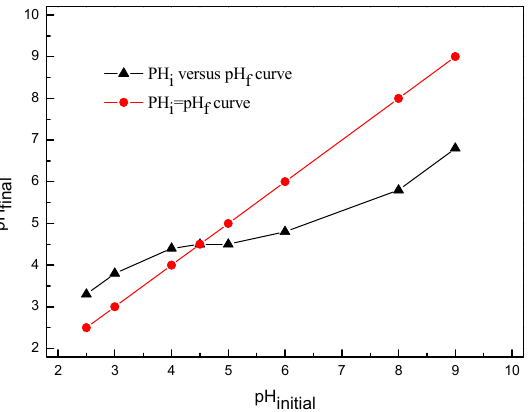
Figure 12. Plot of final pH versus initial pH for determination of pH pzc.